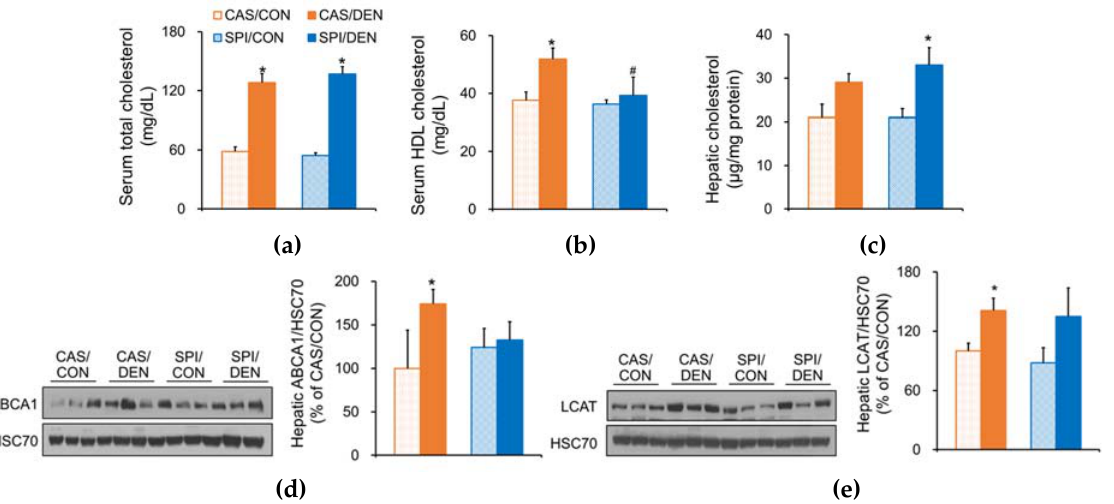
Figure 4. Effects of maternal diet on cholesterol metabolism in DEN ‐ treated male rat offspring. Serum (a) total cholesterol and (b) high ‐ density lipoprotein ‐ cholesterol, and (c) hepatic cholesterol levels ( n = 6 − 9 / group). Hepatic protein levels of ( d ) ATP binding cassette subfamily A member 1 (ABCA1) and ( e ) lecithin cholesterol acyltransferase (LCAT) were determined by immunoblotting analysis, and were normalized to heat shock cognate protein 70 (HSC70) protein levels ( n = 3/group). Results are expressed as means ± SEM. * Significantly different from the maternal diet ‐ matched CON group at p < 0.05. # Significantly different from the CAS/DEN group at p < 0.05 (by one ‐ way ANOVA with Duncan’s multiple comparison test).